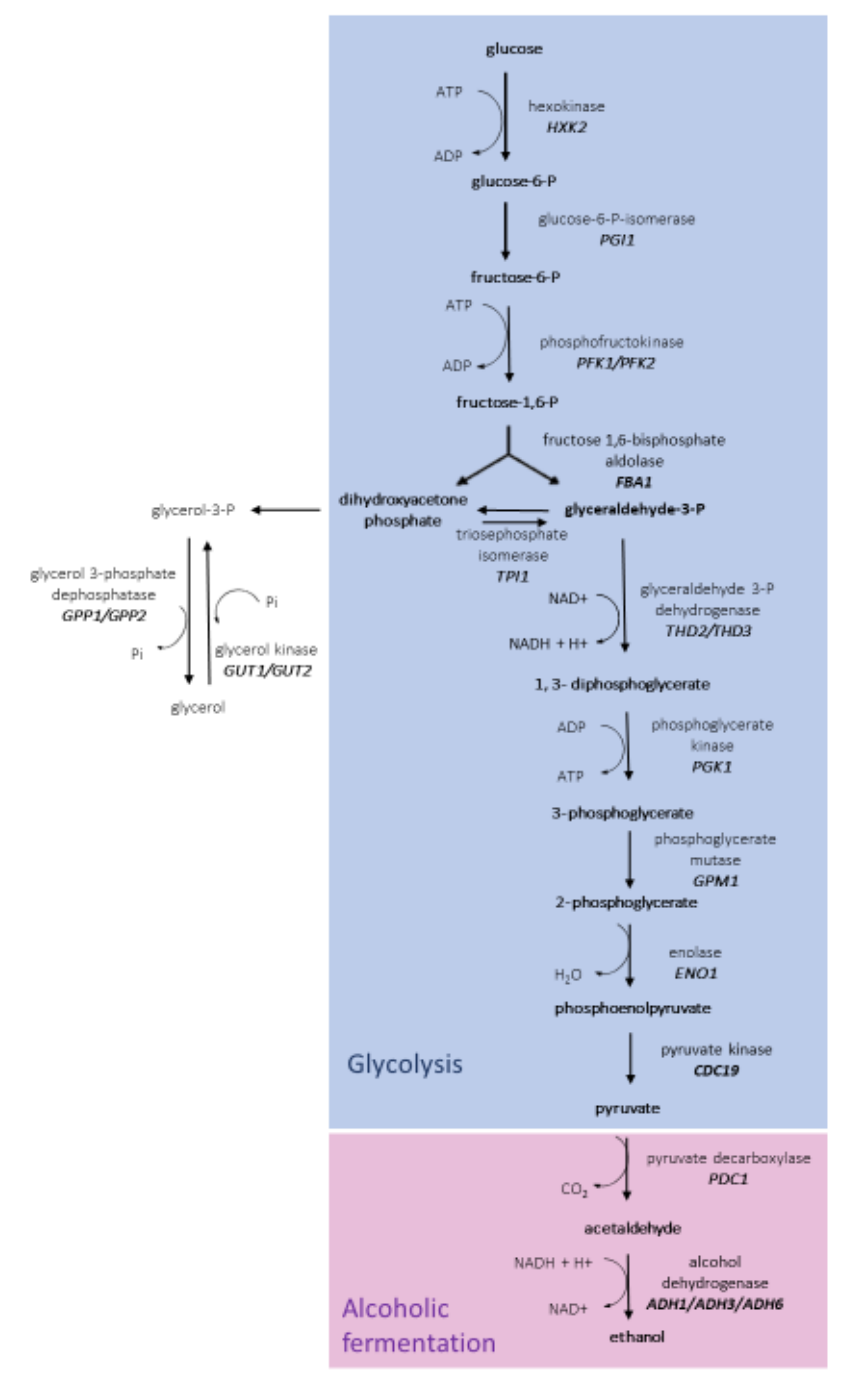
Figure 3. Glycolysis and alcoholic fermentation pathways in yeast. Genes putatively predicted to be involved in the catabolic pathway based on sequence data from genomic analyses of Hanseniaspora vineae strains are presented.